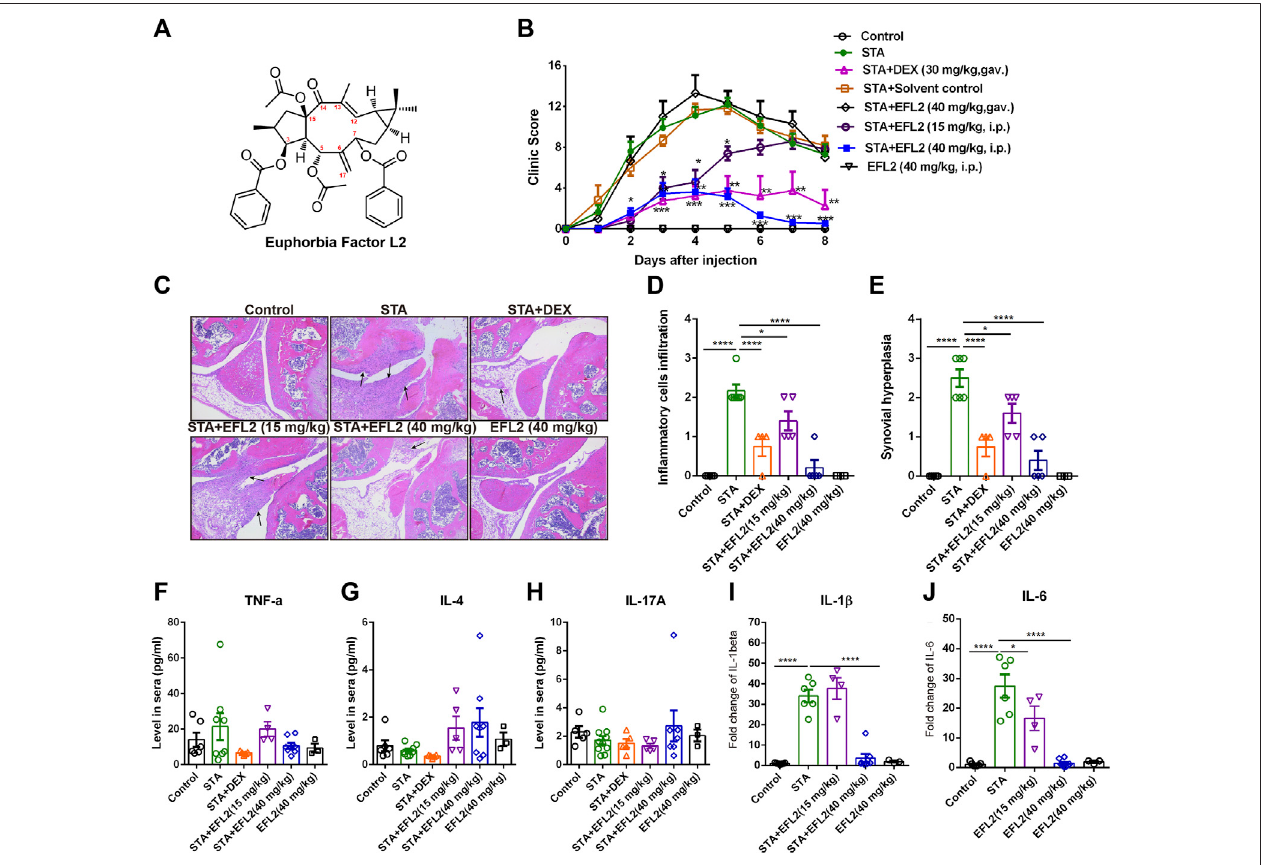
FIGURE 1 | Euphorbia factor L2 effectively alleviates K/BxN serum transfer arthritis (STA) in mice (A) Chemical structure of EFL2 (C 38 H 42 O 9 , molecular weight (cid:1) 642.735) (B) Arthritic index in each group was recorded every day after serum injection (day 0) (C) Representative hematoxylin and eosin (H.E.) staining images of the kneejoints.Assessmentofin fl ammatorycellin fi ltration (D) andsynovialhyperplasia (E) inthekneejointsfromthecontrol(n (cid:1) 6),STA(n (cid:1) 8),STAmicetreatedwithDEX(n (cid:1) 5) or EFL2 (15 or 40 mg/kg) (n (cid:1) 5 – 8) and mice solely treated with EFL2 (40 mg/kg) (n (cid:1) 3) (F-J) TNF- α (F) , IL-4 (G) , IL-17A (H) , IL-1 β (I) and IL-6 (J) levels in the blood ofcontrol,STAand STAmicetreatedwithDEX orEFL2. Datarepresentthemeanvalues ± SEM.* p < 0.05,** p < 0.01,*** p < 0.001wereconsideredassigni fi cant.